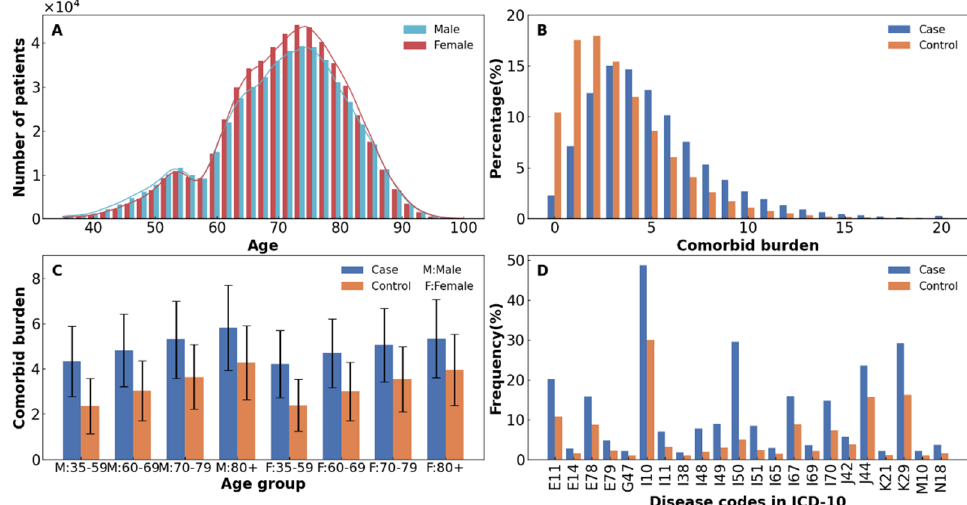
Figure 1. Demographic characteristics and comorbidity statistics. ( A ) Sex-specific age distribution for IHD patients. ( B ) Distribution of the number of comorbid burdens in patients with IHD and controls. ( C ) Mean number of comorbidities in IHD patients and controls by sex and age. The error bar represents mean ± standard deviation. ( D ) Enrichment comorbidities in IHD patients: prevalence of diagnosis ≥ 1% in both case and control, prevalence increased over 0.5 times increase in case (color blue) than controls (color orange). E11: diabetes mellitus; E14: unspecified diabetes mellitus; E78: disorders of lipoprotein metabolism and other lipidemias; E79: disorders of purine